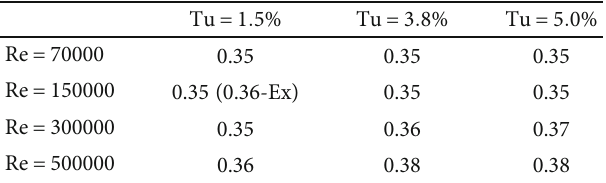
Table 3: Detachment positions ( x / L ) with D12-7.